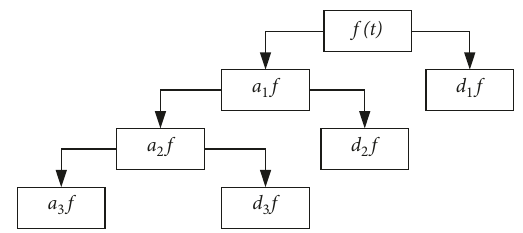
Figure 3: Decomposition and reconstruction of wavelet with scale